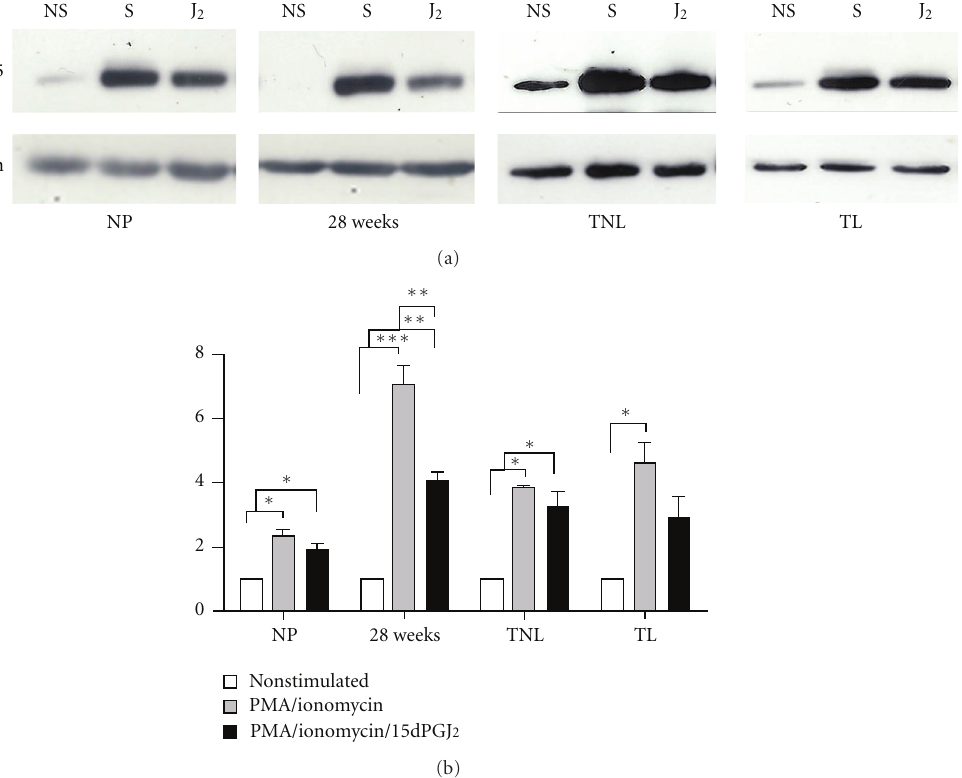
Figure 4: The e ff ect of 15dPGJ2 on NF- κ B p65 phosphorylation in peripheral blood mononuclear cells. PBMCs were treated as previously described before being extracted and levels of phosphorylated p65 (p-p65) examined using immunoblotting. Representative immunoblots are shown for each gestational time point (a). Immunoblots were reprobed for β -actin as an internal loading control. Densitometric analysis of the immunoblots was conducted revealing a significant increase in p-p65 levels upon stimulation with PMA/ionomycin in all samples (b). A significant decrease in PMA/ionomycin stimulated p-p65 was observed following 15dPGJ 2 treatment in 28-week samples. The capacity of 15dPGJ 2 to inhibit PMA/ionomycin-induced p-p65 was lost in those samples collected at term. NS: nonstimulated, S: PMA/ionomycin stimulated, and J 2 : 15dPGJ 2 pretreatment. E ff ect of treatment was examined for statistical significance at each gestational timepoint using ANOVA with Bonferroni’s multiple comparison test; ∗∗∗ P < 0 . 001, ∗∗ P < 0 . 01 and ∗ P < 0 .